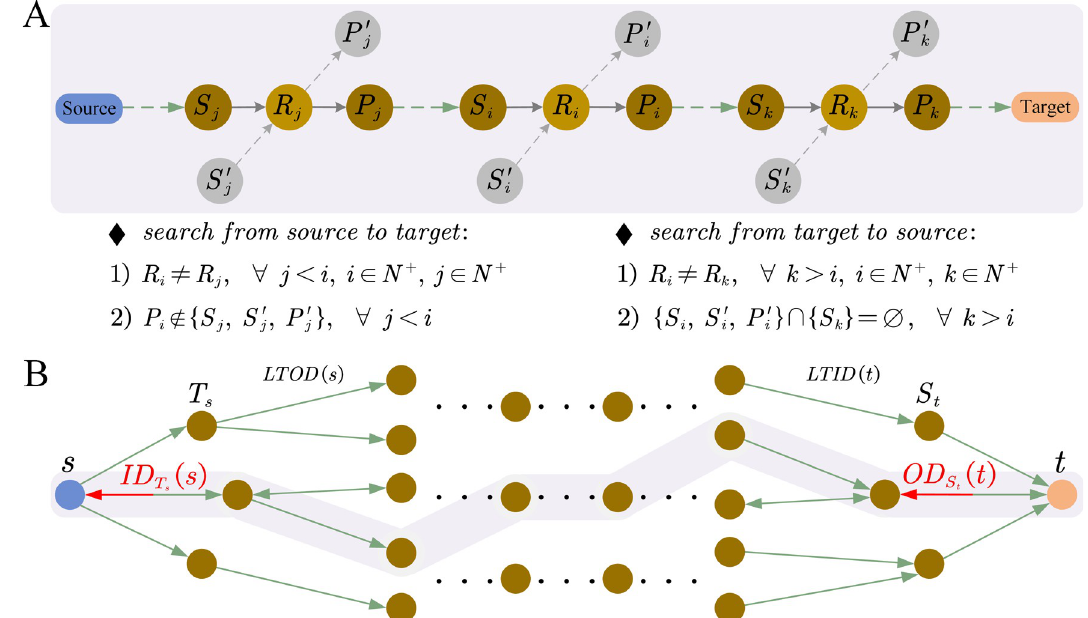
Fig 3. Illustration of the CSS. (A) Two constraints that biologically feasible and linear metabolic pathways need to meet. The two constraints are labeled as ‘1)’ and ‘2)’. The green dashed arrow means multi-step reactions and the gray dashed arrow indicates implicit access of compound nodes (substrates or products). (B) CSS based on local total in-out degree (LTIOD). LTOD ( s ) indicates the local total out degree of initial substrate and LTID ( t ) denotes the local total in degree of target product. Forward search, from initial substrate (Source) to target product (Target). Reverse search, from target product (Target) to initial substrate